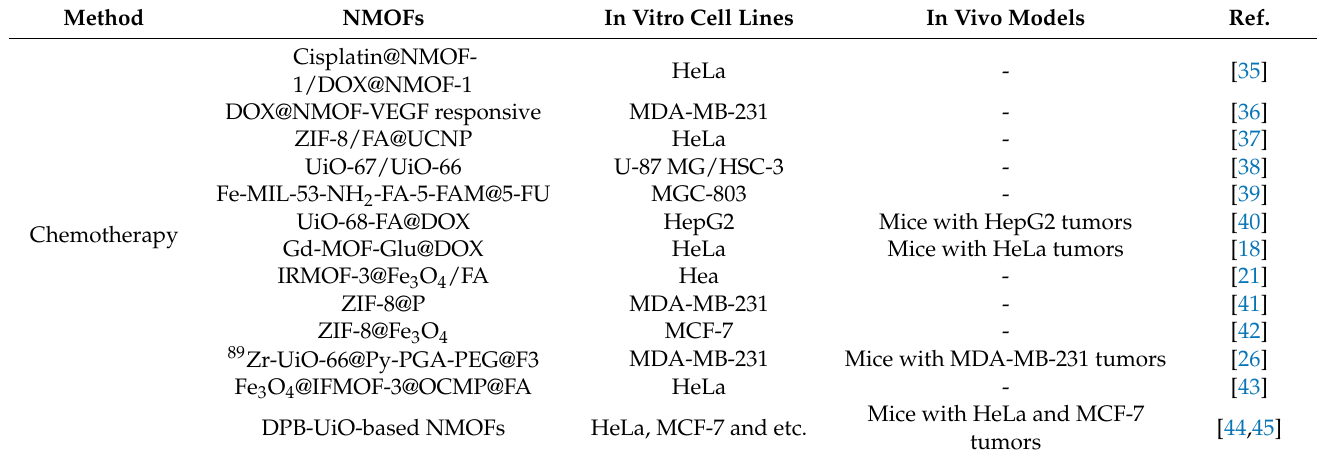
Table 2. A literature survey on NMOFs in individual cancer